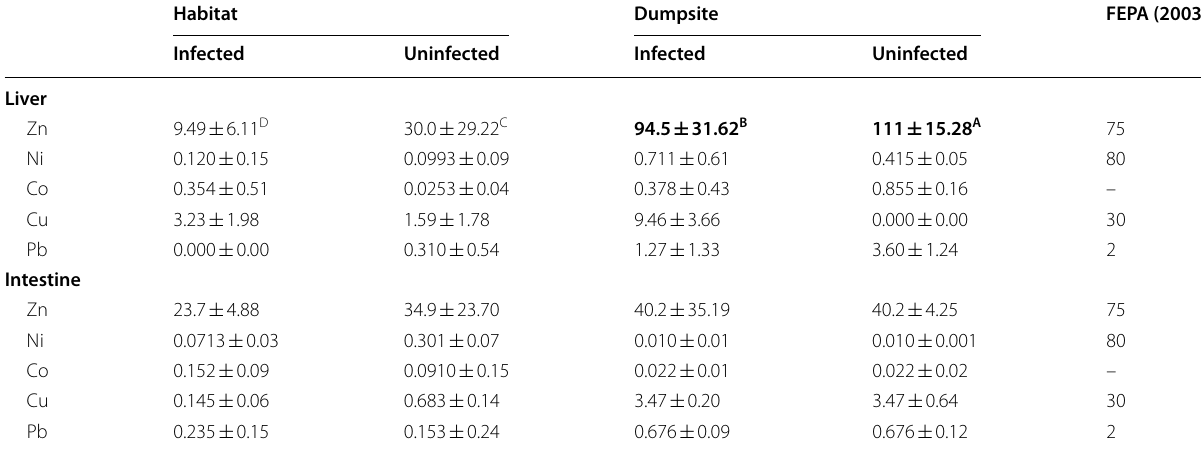
Table 1 Concentrations of trace metals (mg/kg, Mean with the nematode Cosmocerca sp. within the natural habitats and dumpsites from Lagos metropolis, Nigeria (March 2020–February 2021)